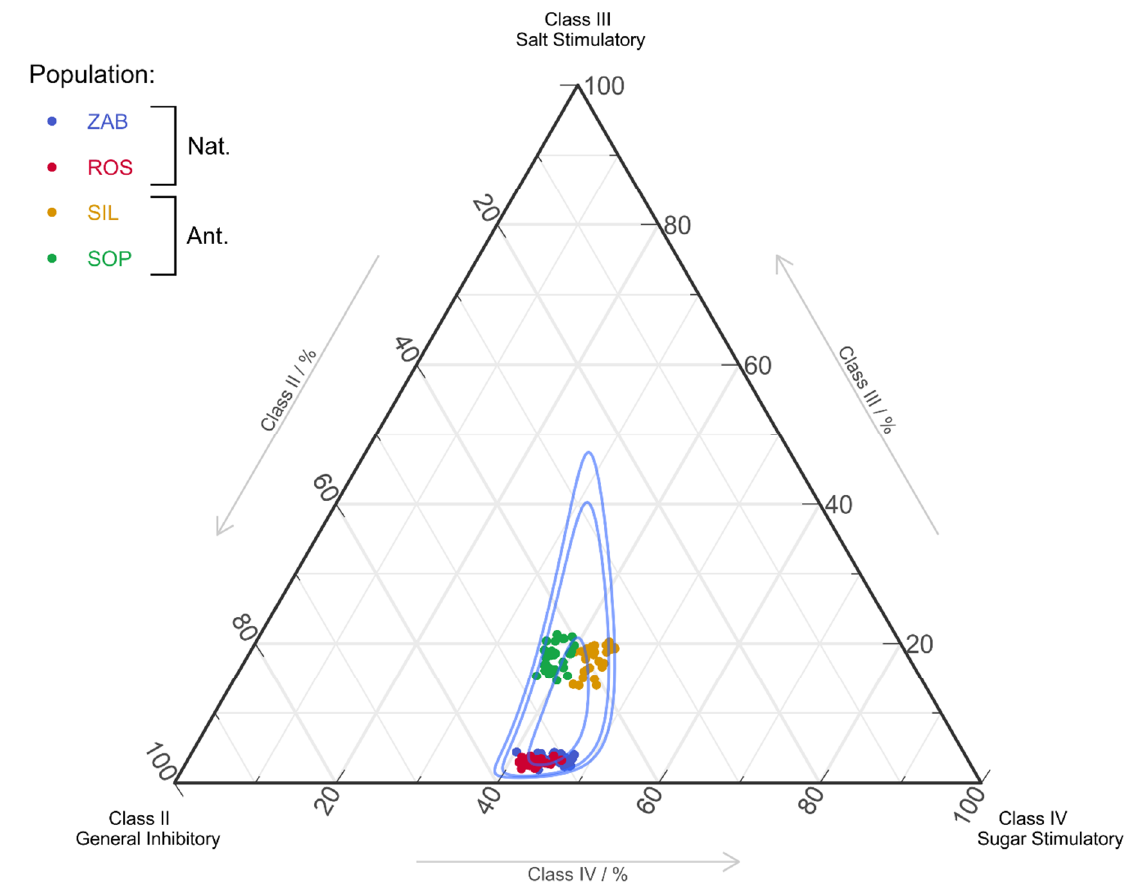
Figure 3. Ternary plot of amino acid classes for Epipactis palustris natural (Nat.) and anthropogenic (Ant.) populations: II (Asp, Glu, His, Arg, Lys), III (Pro), and IV (Val, Met, Trp, Phe, Ile, Leu). Blue lines show 50%, 90%, and 95% confidence intervals via the Mahalanobis Distance and use of the Log–Ratio Transformation. The first class of AAs (Asn, Gln, Ala, Cys, Gly, Ser, Thr, Tyr) does not affect the chemoreceptors of fly (data not shown). AAs’ abbreviations and full names are present in Table